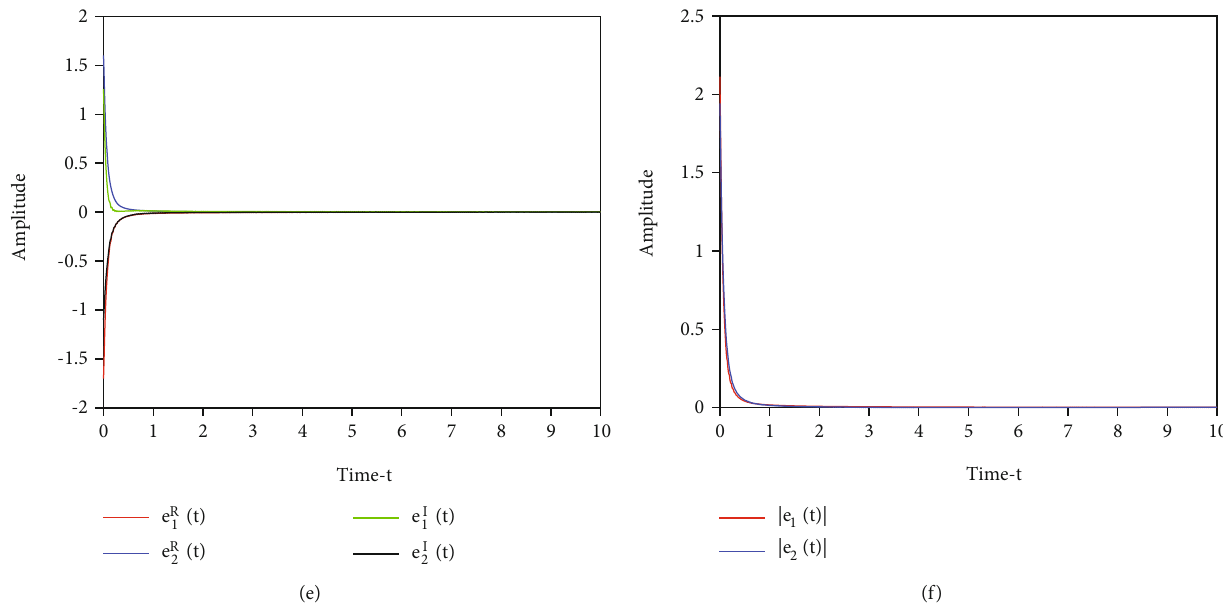
Figure 5: (a, b) The real parts of synchronization state trajectories with controller (24). (c, d) The imaginary parts of synchronization state trajectories with controller (24). (e) The error trajectories with controller (24). (f) The error modulus trajectories with controller